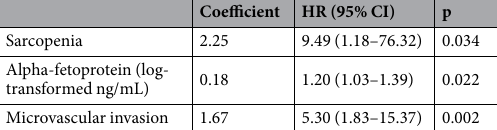
Table 3. Multivariable analysis. Variables with p < 0.05 during univariable analysis were included in the model